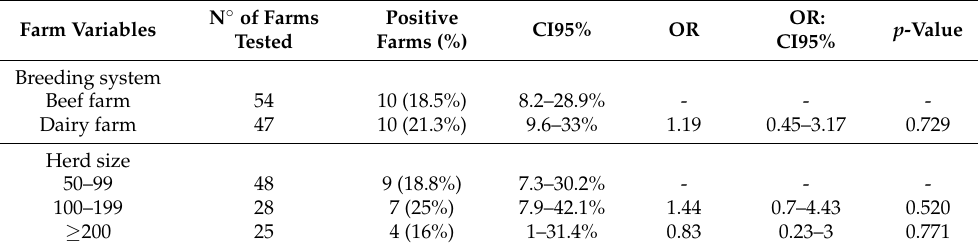
Table 2. C. difficile distribution on the two breeding systems and different herd sizes.